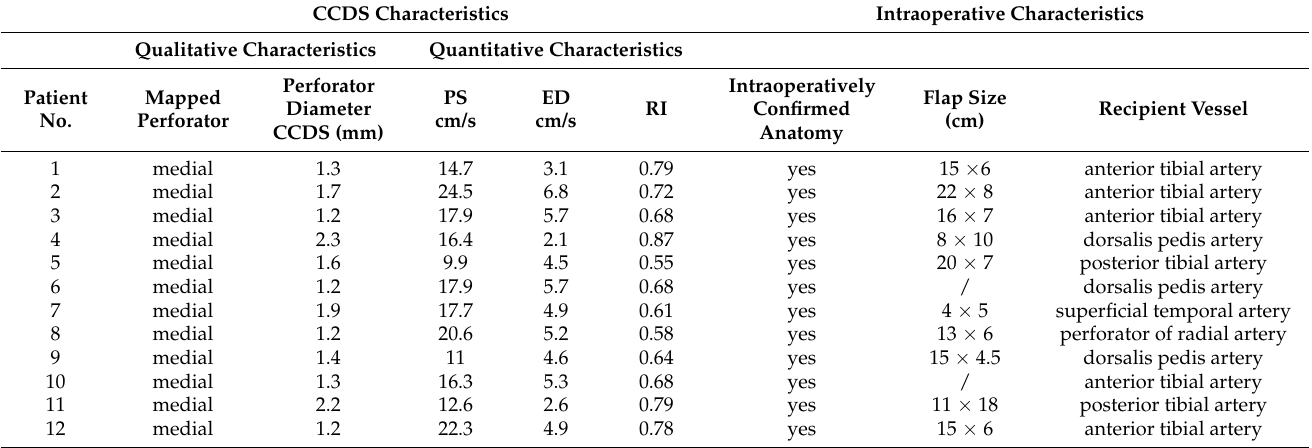
Table 3. Flap and perforator